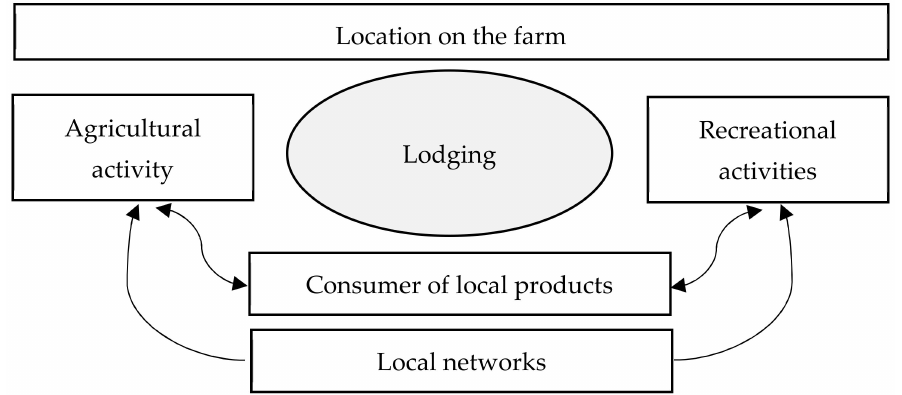
Figure 4. Linkages between agriculture and